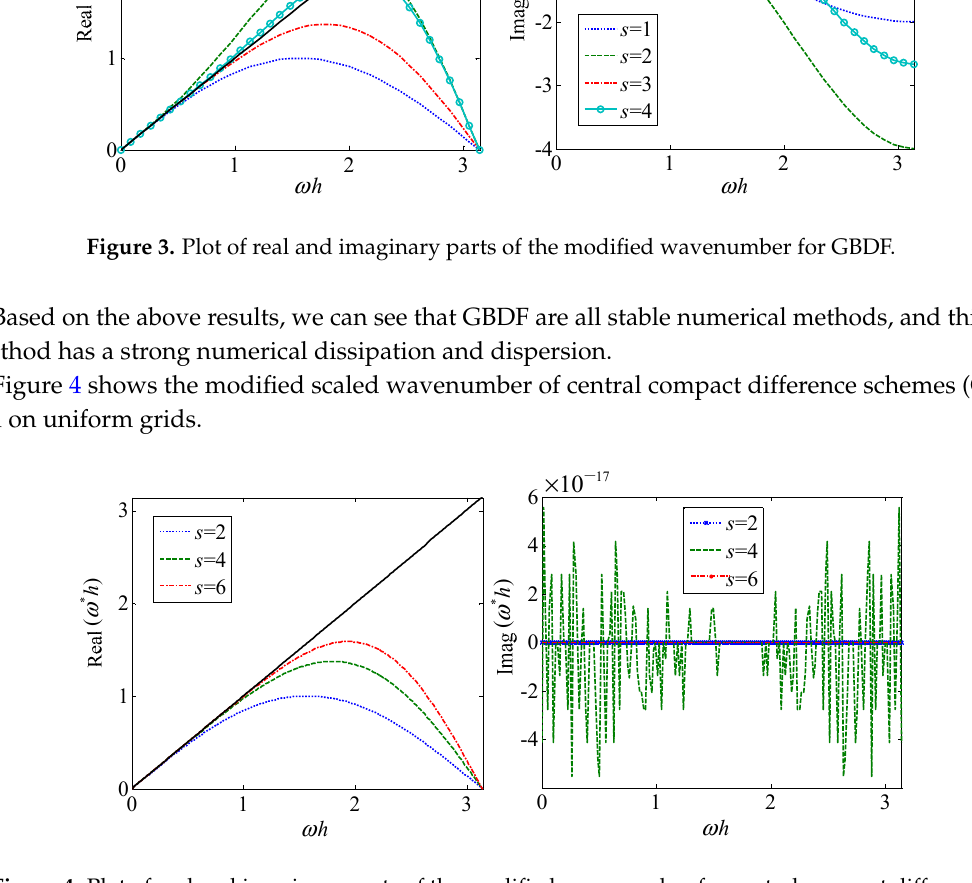
( b ) ( b ) Figure 5. ( a ) Plot of real and imaginary parts of the modified wavenumber for GAMs with even s ; ( b ) plot of real and imaginary parts of the modified wavenumber for GAMs with odd s .